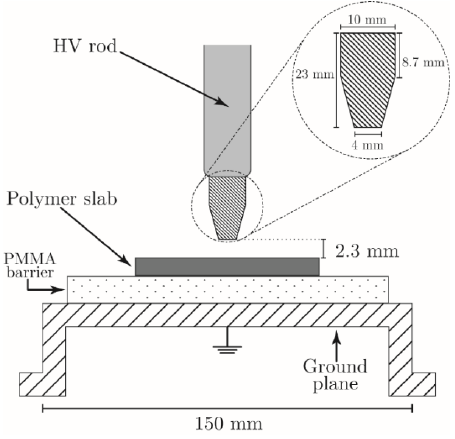
Figure 1. Experimental setup.